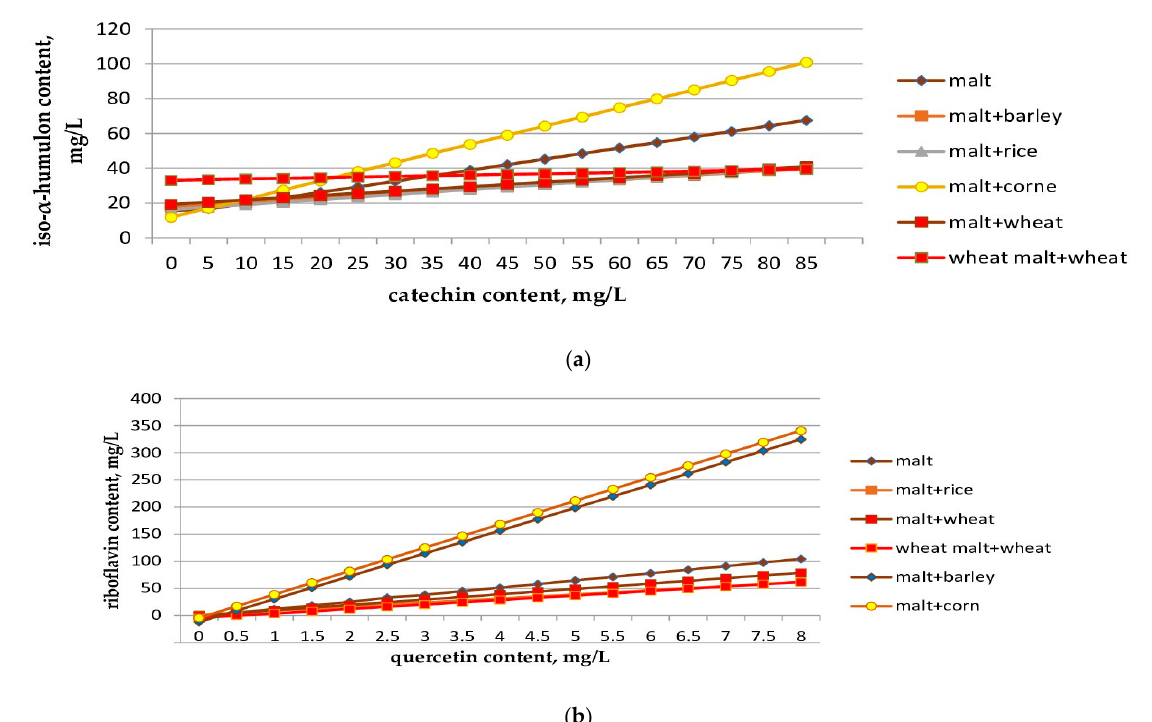
Figure 2. The change in the dynamics of iso- α -humulone from catechin ( a ) and riboflavin from quercetin ( b ) during fermentation.